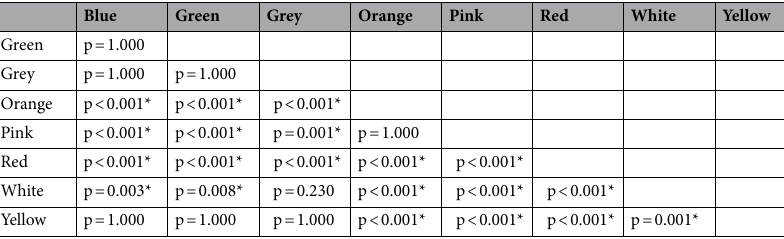
Table 3. Post-hoc differences in the first expectation block for all colors (both modalities merged). The Bonferroni correction was used for all post-hoc tests. Significant comparisons are marked with *.